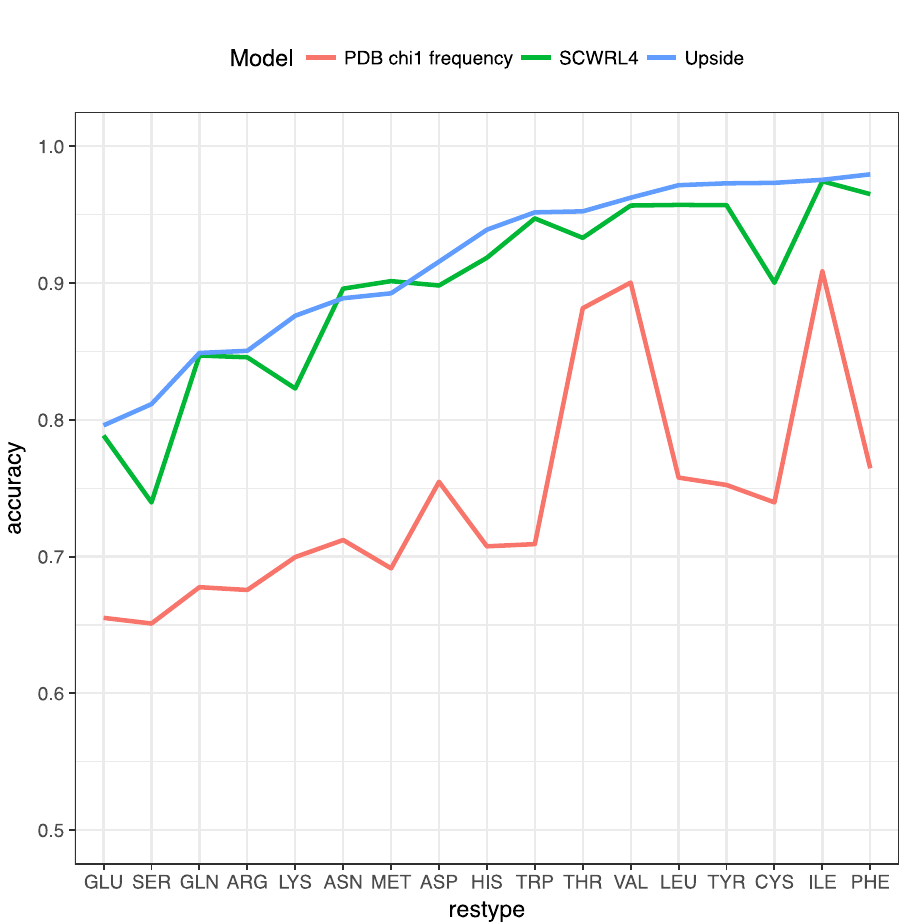
Fig 6. Comparison of χ 1 prediction accuracy for Upside and SCWRL4, ordered by Upside accuracy. The “PDB χ 1 frequency” line represents the accuracy of the NDRD rotamer library without any interactions; this library is used in both Upside and